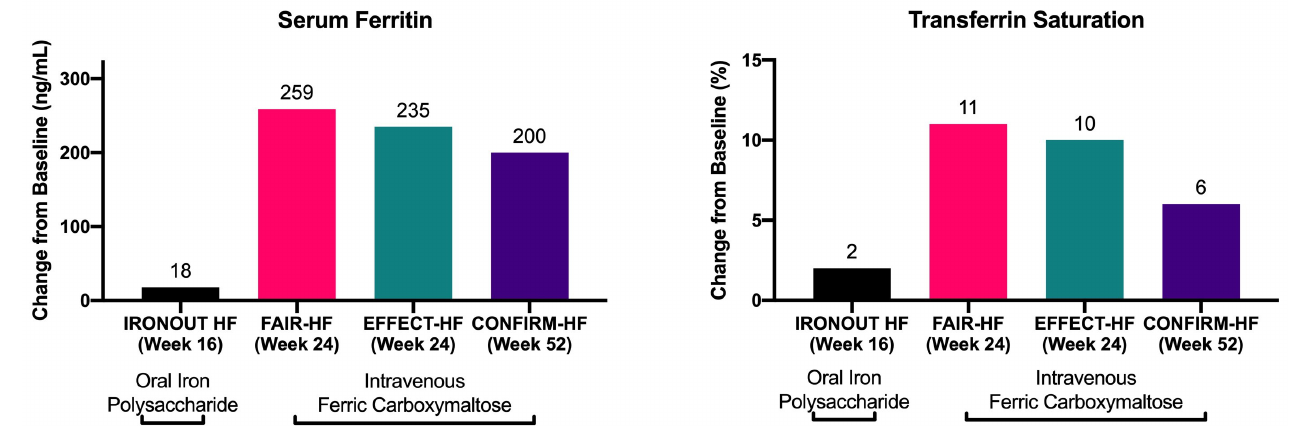
Figure 2. Comparison of iron repletion regimens in patients with heart